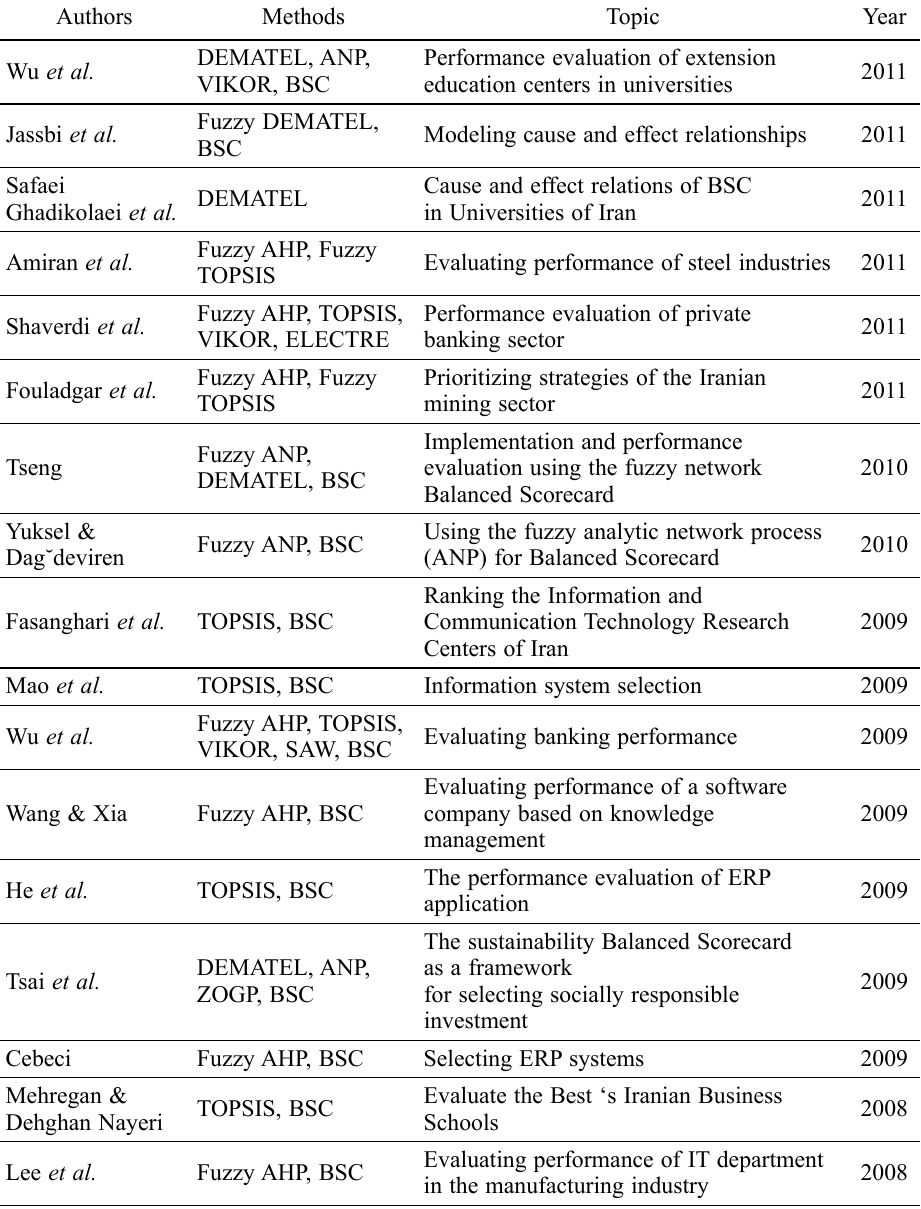
Table 1. Review of MCDM methods with BSC (After